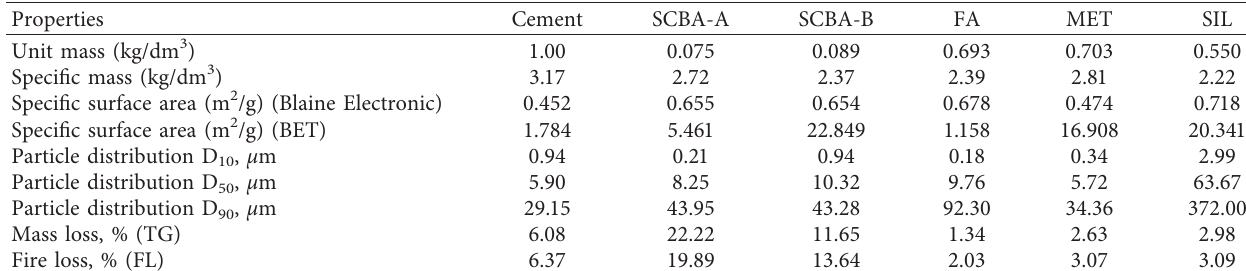
Figure 3: Cells for chloride migration assay and chloride migration assay preparation. Table 2: Summary of the materials characterization.